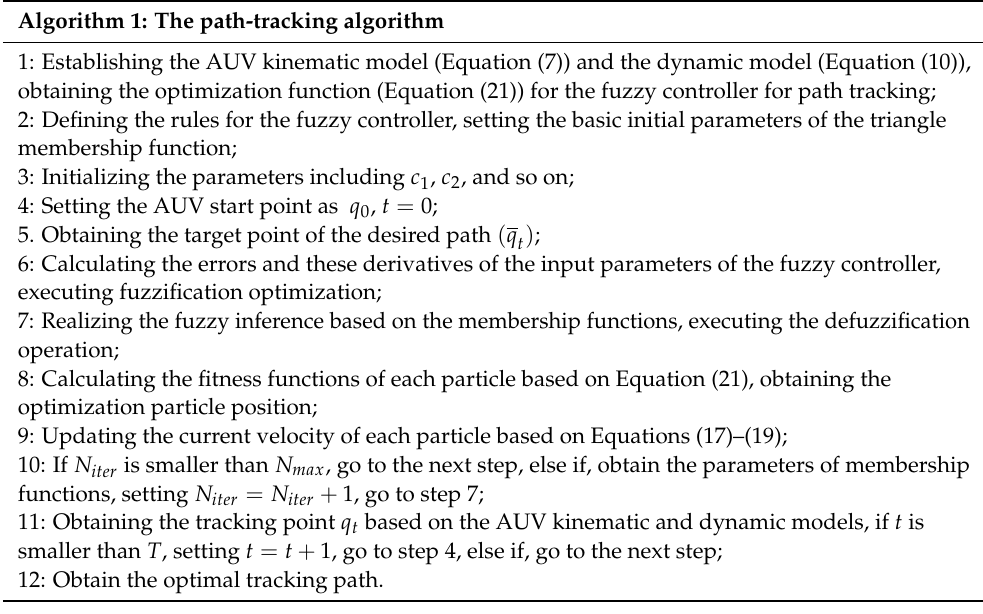
Algorithm 1: The path-tracking